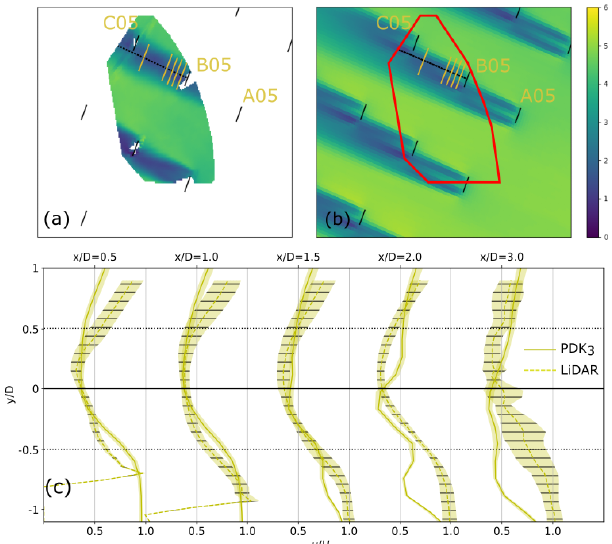
Figure 21. Comparison of LES time-averaged velocity (b) against lidar wake measurements (a) for case PDk 3 and turbine B05. (c) Comparison of velocity wake deficit at downstream locations from turbine B05. Lidar data at x/D = 4 . 0 were not available. Line at y/D = 0 is perpendicular to the turbine orientation from SCADA data. Shaded area represents 95% confidence interval on the